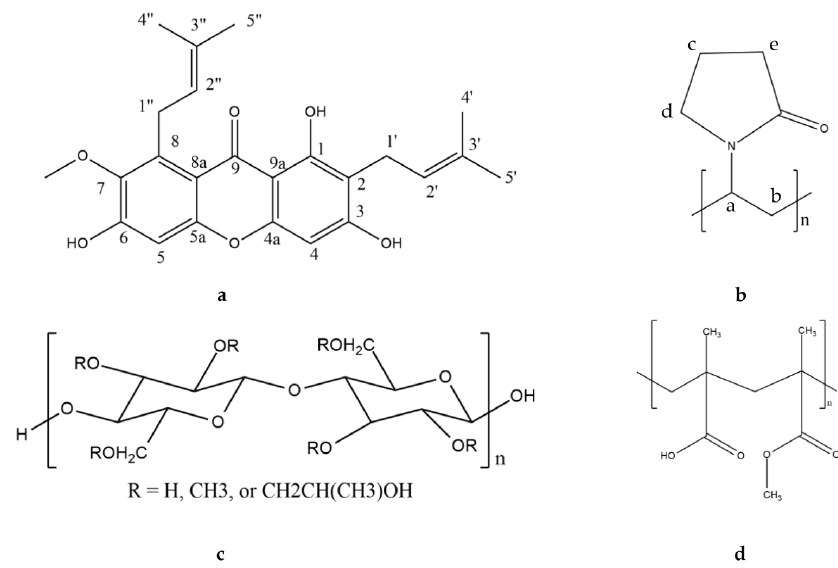
Figure 1. Chemical structures of ( a ) AM, ( b ) PVP, ( c ) HPMC, and ( d )